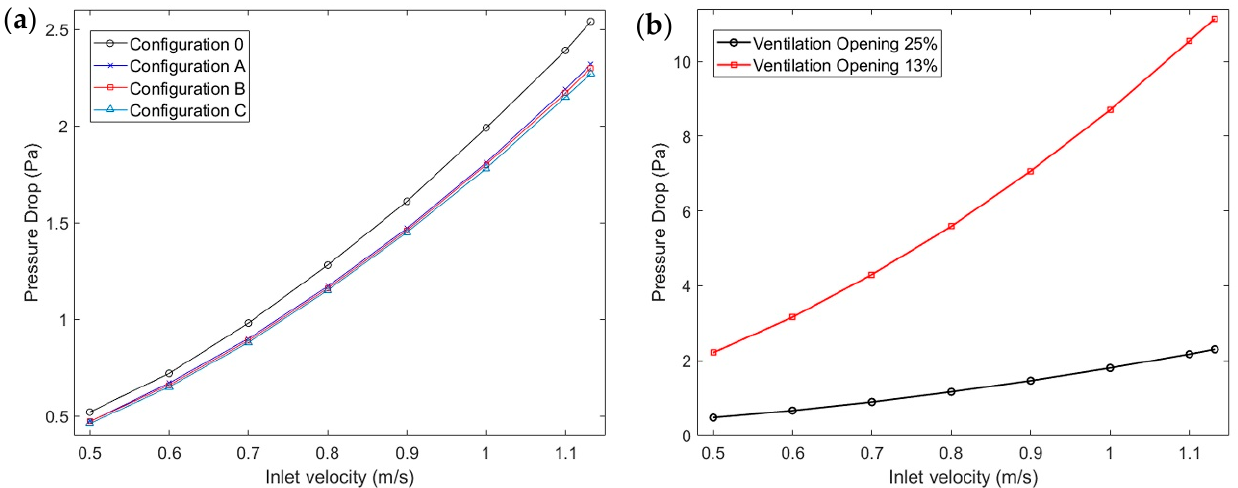
Figure 5. Pressure drop against inlet air velocities for ( a ) different AMW unit configurations and ( b ) Configuration B with different percentages of ventilation opening.